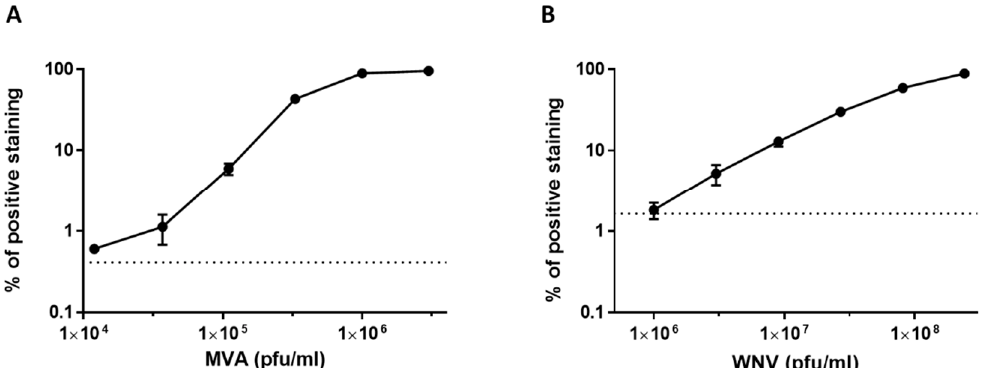
Figure 8. Dose response analysis of MVA and West Nile virus spiked to fourfold-diluted human serum after capture with Vero cells. ( A , B ) The cells were harvested and diluted to achieve 20,000 cells per tube. Next, WNV or MVA spiked to fourfold diluted human serum were added to the cells and incubated for one hour with shaking at 4 ◦ C to allow attachment. The cells were then immuno-labeled with a relevant fluorescent antibody and analyzed by FACS. The results shown are average values of positive staining ± SEM from 3 and 4 experiments in biological duplicates for MVA and WNV, respectively.